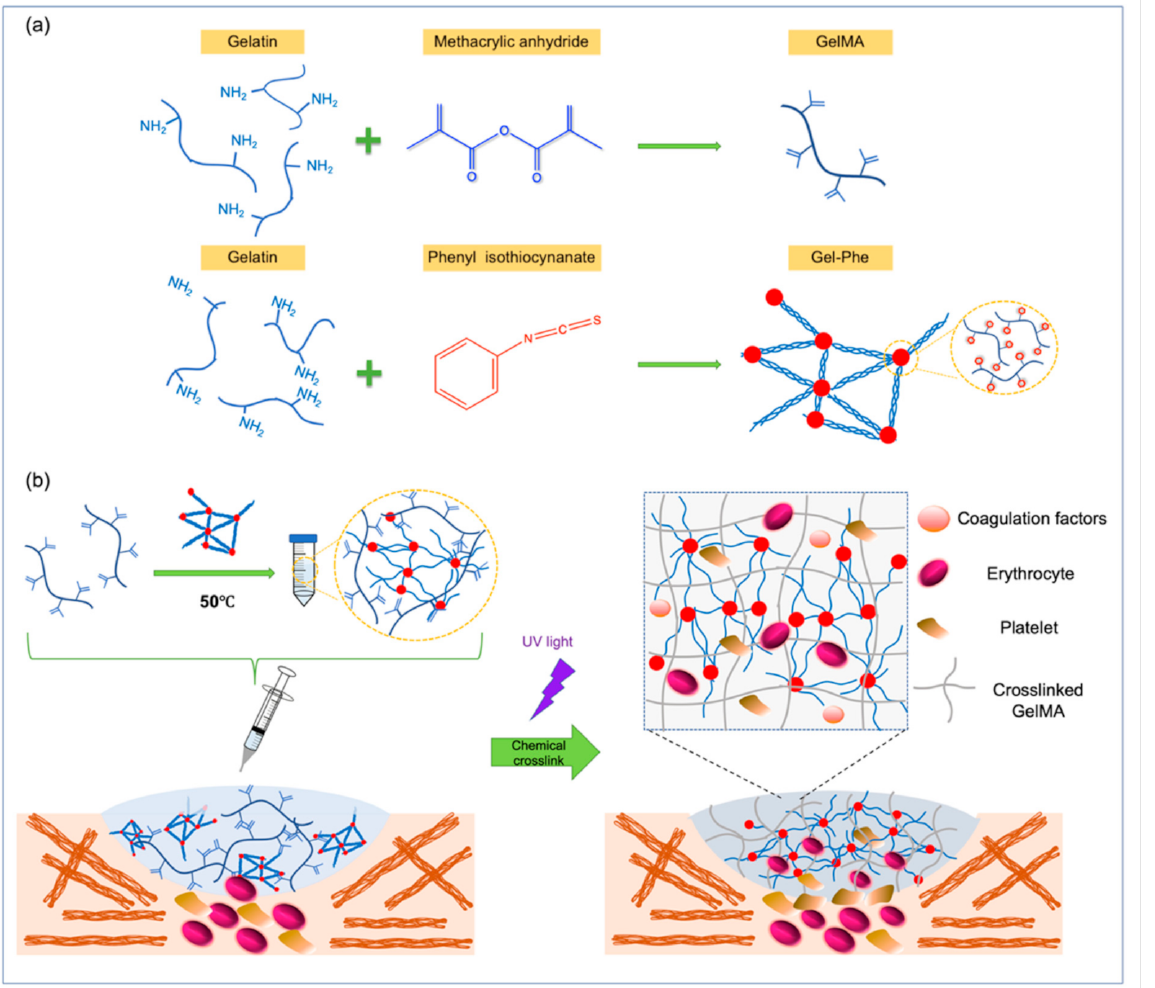
Figure 1. ( a ) Representation of the synthesis of GelMA and Gel-Ph, and ( b ) schematic illustration of an injectable GelMA/Gel- Phe bioadhesive crosslinked using UV light for